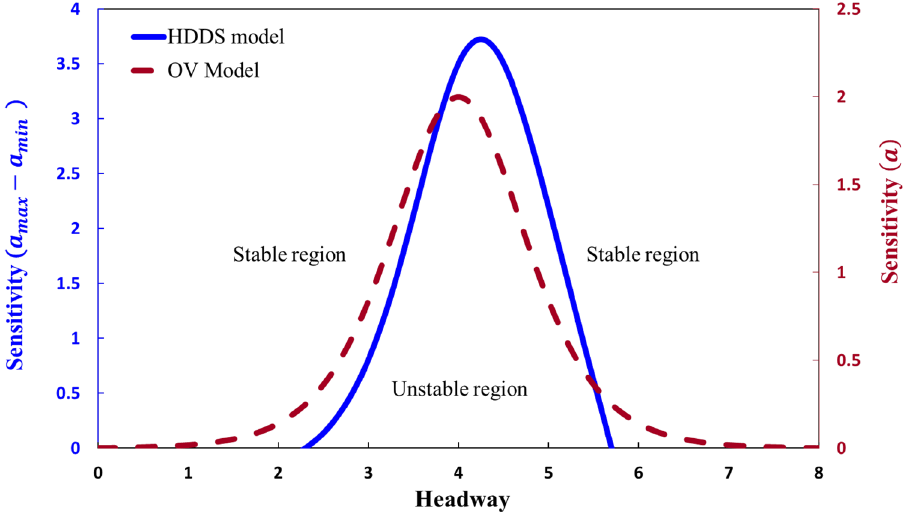
Figure 3. Phase diagram for sensitivity–headway space. The solid blue line indicates the neutral stability history of the HDDS model whereas dashed red line for the conventional OV